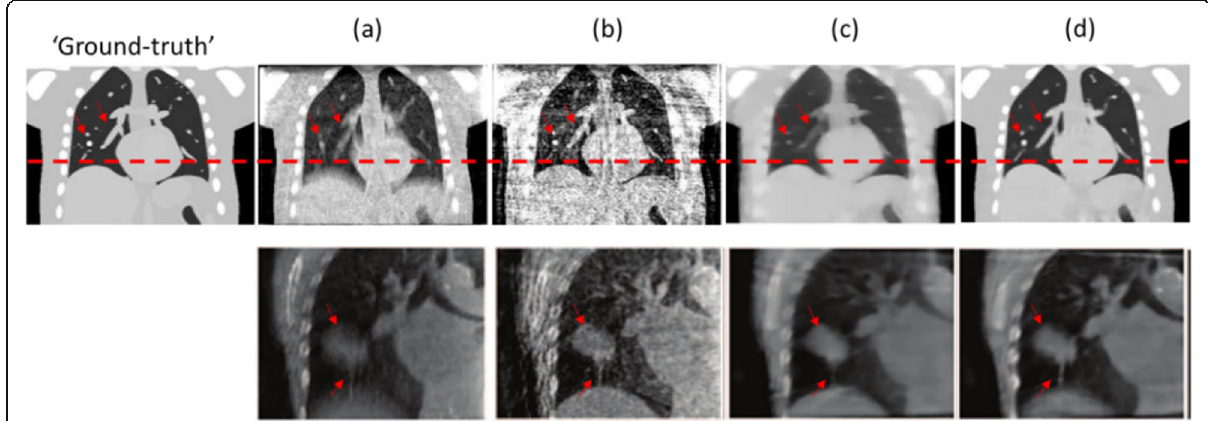
Fig. 2 Comparison between the reconstructed images by different methods. a Non-phase-sorted FDK images using projections from all respiratory phases; b Phase-sorted FDK images using only projections from the peak-expiration phase; c Peak-expiration phase image by the algebraic reconstruction technique with total variation-regularization; d Peak-expiration phase image by simultaneous motion estimation and image reconstruction. The first row shows the reconstructed images of a digital NCAT phantom [43]. The second row shows the reconstructed images of a real lung cancer patient from clinical projections. The “ Ground-truth ” image of the NCAT phantom was also presented as a reference. FDK: Feldkamp-Davis-Kress; NCAT: Non-uniform rational B-spline cardiac and